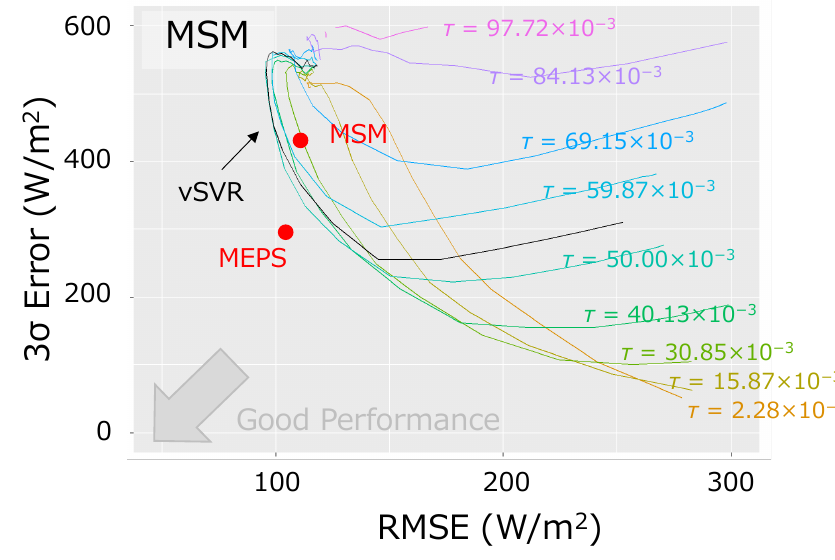
Figure 11. RMSE vs. 3 σ error for the MSM- ν SVR and